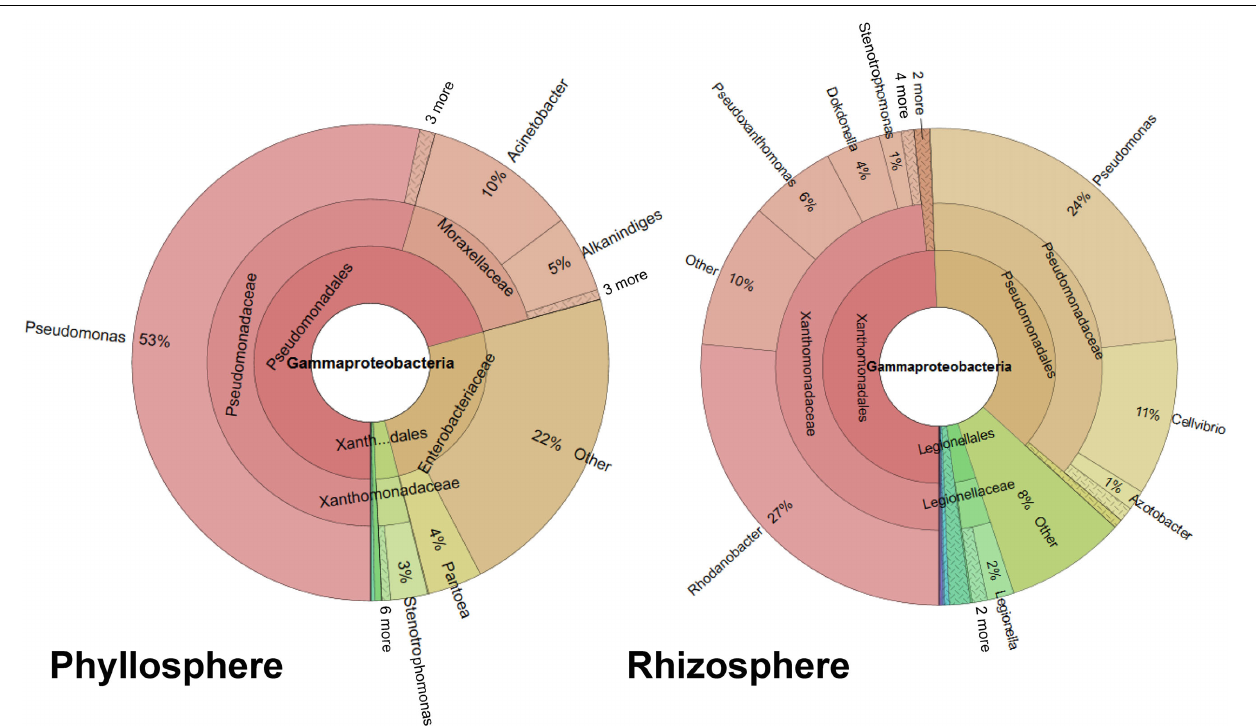
FIGURE 1 | Ring-charts showing the gammaproteobacterial community structure associated with investigated lettuce habitats. The RDP classifier analysis is shown from the mean of 12 samples per